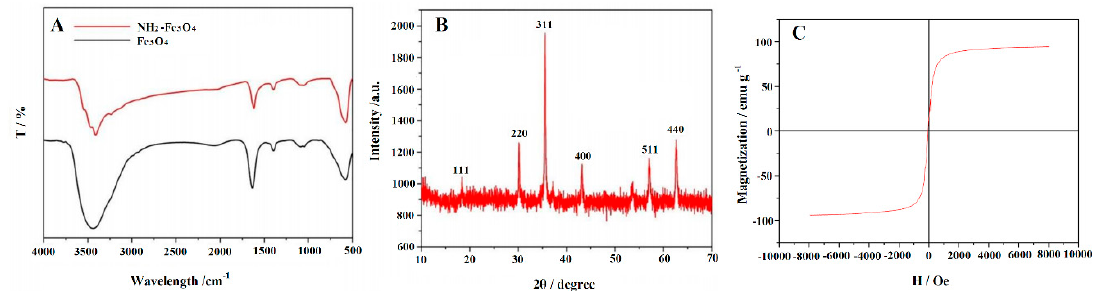
Figure 2. Fourier transform infrared spectroscopy (FTIR) spectra of Fe 3 O 4 NPs and NH 2 -Fe 3 O 4 NPs ( A ), the X-ray diffraction (XRD) pattern of NH 2 -Fe 3 O 4 NPs ( B ) and the vibrating sample magnetometer (VSM) of NH 2 -Fe 3 O 4 NPs ( C ).